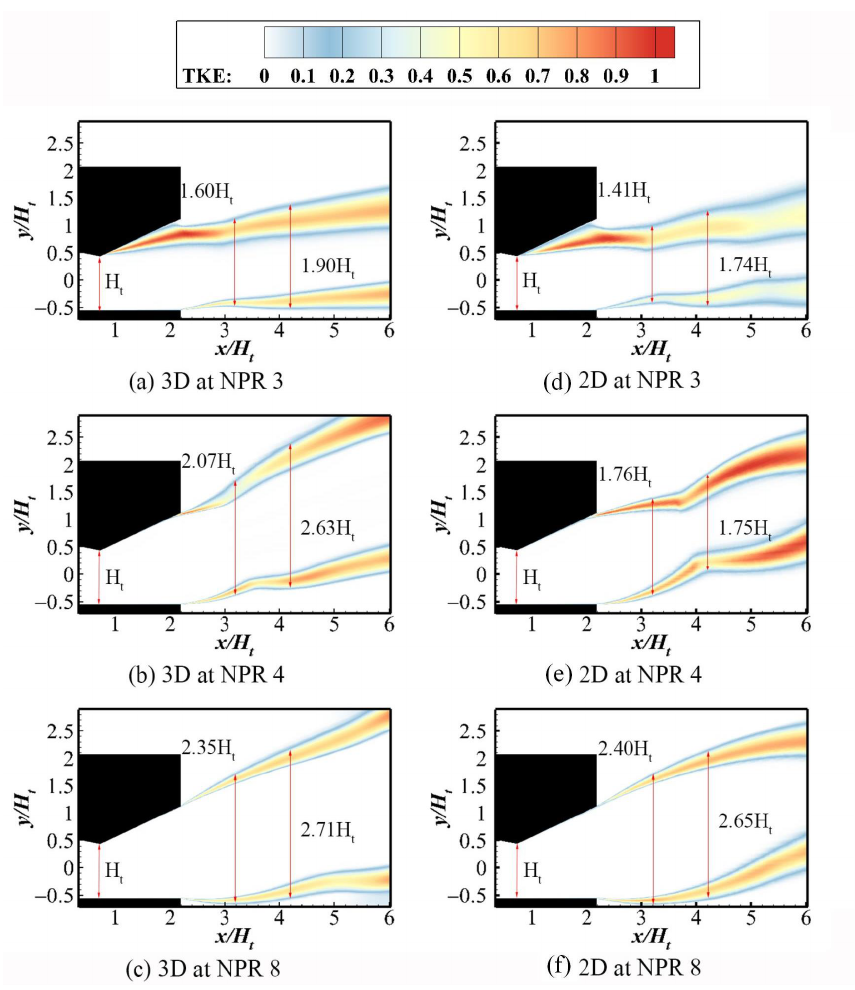
Figure 8. Jet widths at various NPR